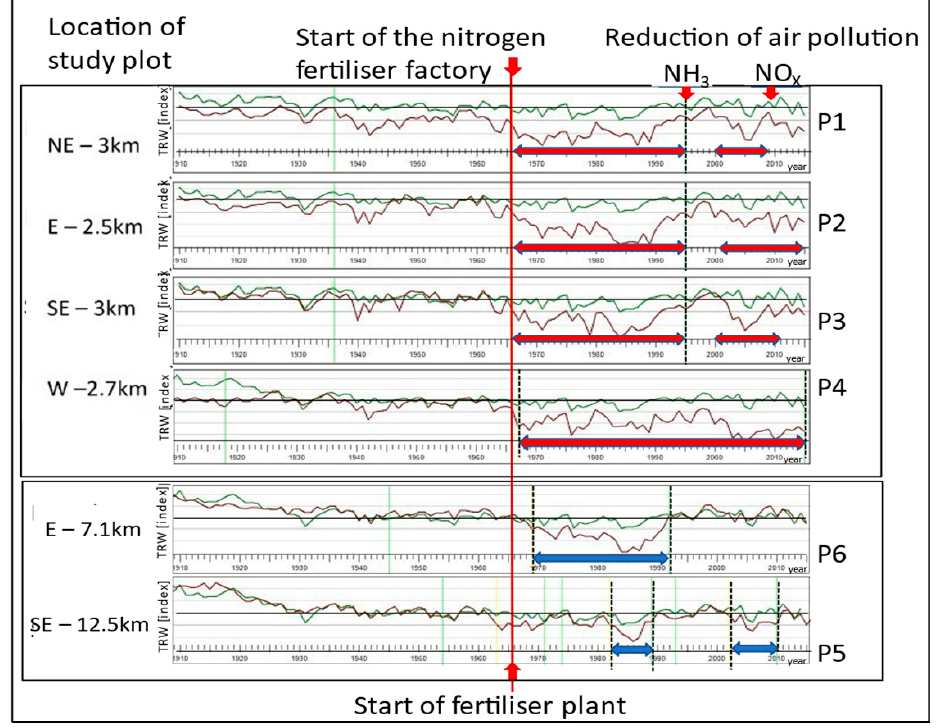
Figure 6. Reductions in the radial growth of the Scots pines growing in the vicinity of Zakłady Azotowe Puławy (selected plots). Explanation of markings: Brown lines—pine chronologies